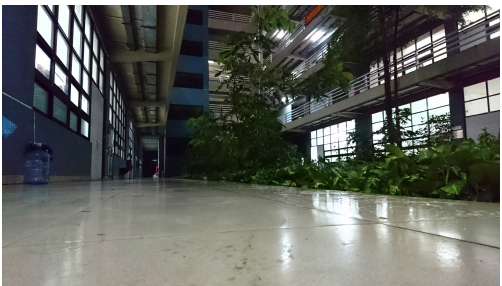
Figure 12. Environment of the experiment on rainy nights, for evaluation of illumination